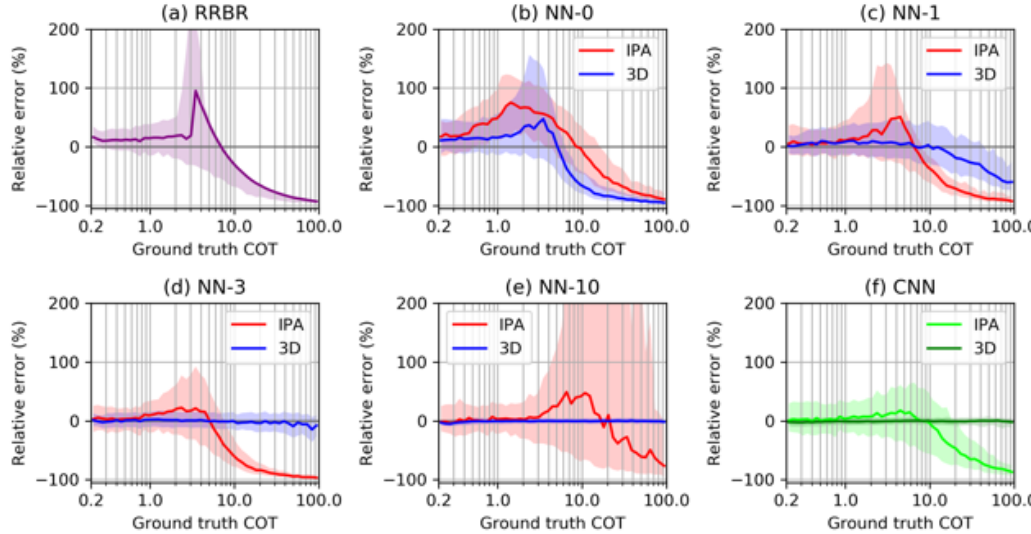
Figure 6. Comparison of relative errors in the estimated COT obtained by various methods summarized in Table 1, namely: ( a ) RRBR method; ( b ) NN-0 method; ( c ) NN-1 method; ( d ) NN-3 method; ( e ) NN-10 method; ( f ) CNN. The solid lines denote the median values and the shaded areas denote ranges between the 25th and 75th percentiles. The NN models were trained using IPA and 3D radiances, respectively, and the estimation errors for the IPA- and 3D-based NN models were evaluated for the 3D radiances as the input.